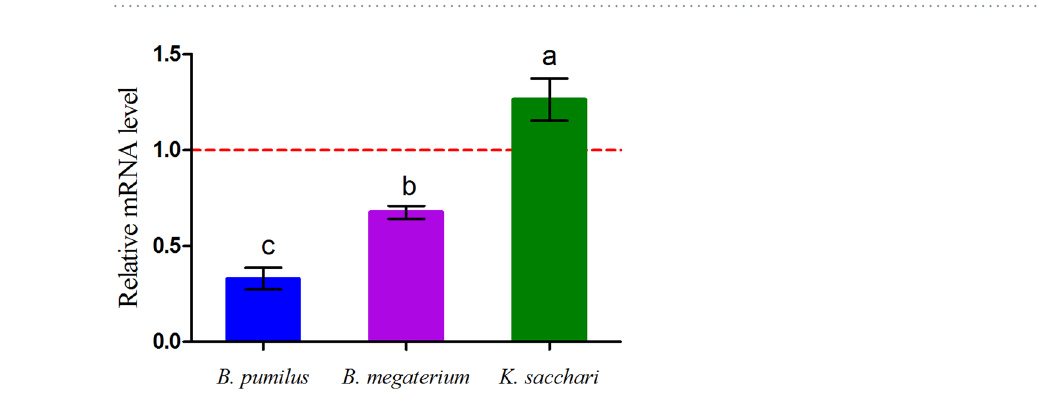
Figure 6. Chemotactic response of the bacteria towards the mixture of detected organic acids at different concentrations evaluated by capillary assay. Columns with different letters are statistically different (LSD test, p < 0.05).